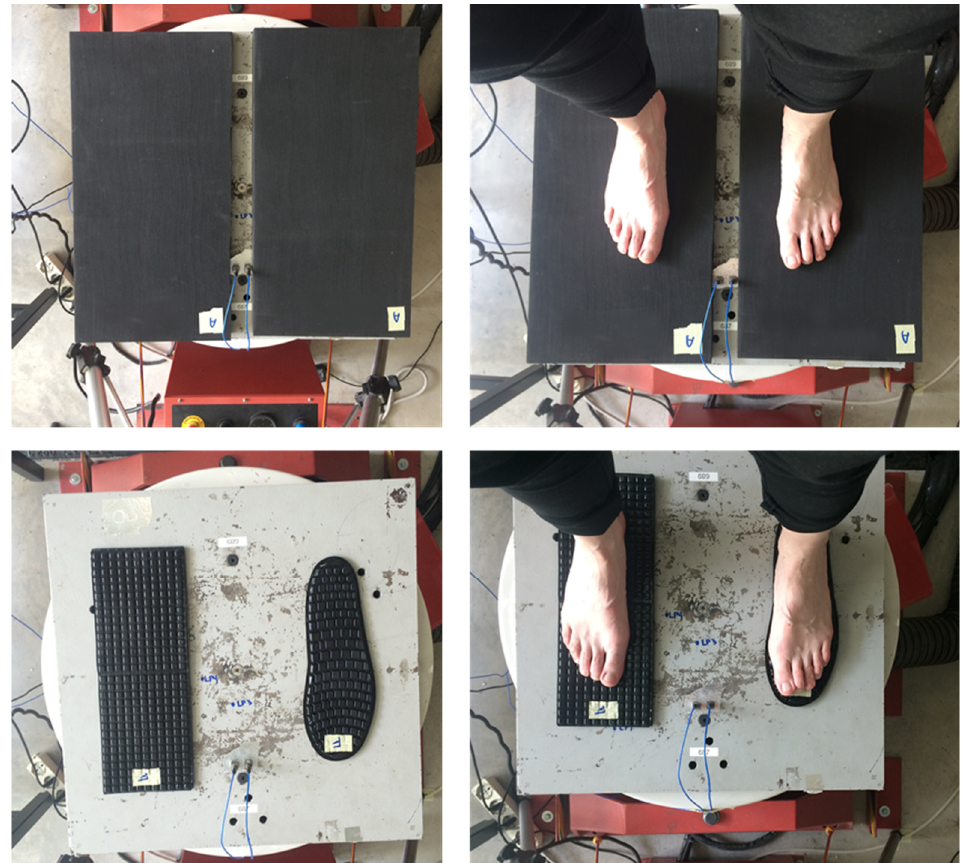
Figure 3. Example midsole material evaluated ( top left ) and participant standing on the shaker and midsole material ( top right ). An example of insole material evaluated ( bottom left ) and participant standing on the insole material ( bottom right ) is also shown.